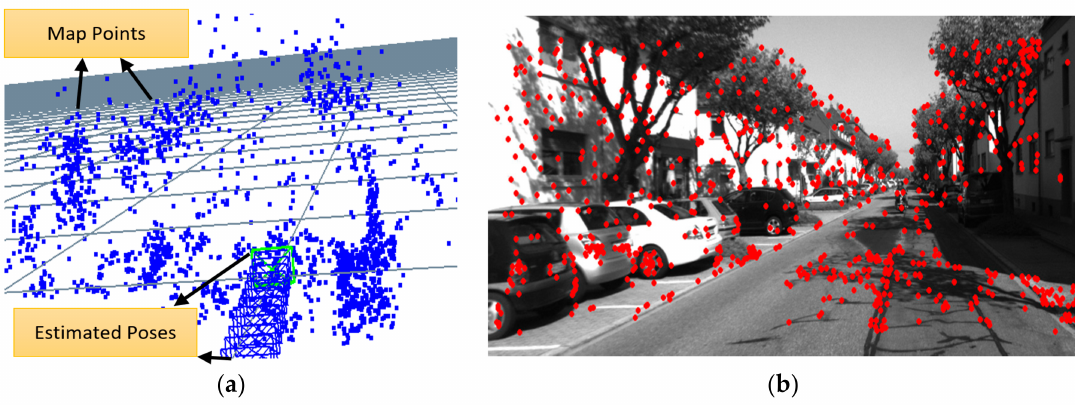
Figure 1. An illustration showing: ( a ) local 3D map and ( b ) detected 2D image features. The goal is to find the correspondence between each 3D map point and detected 2D feature. Sample image from KITTI